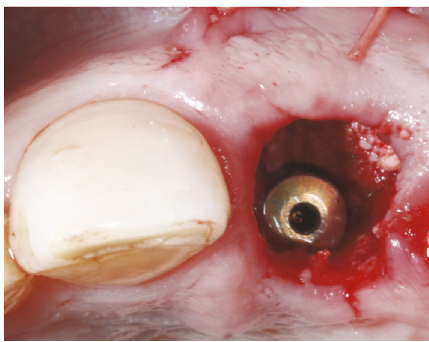
Figure 5: Occlusal view of the reconstructed socket prior to the installation of the provisional with a concave subgingival contour without occlusal